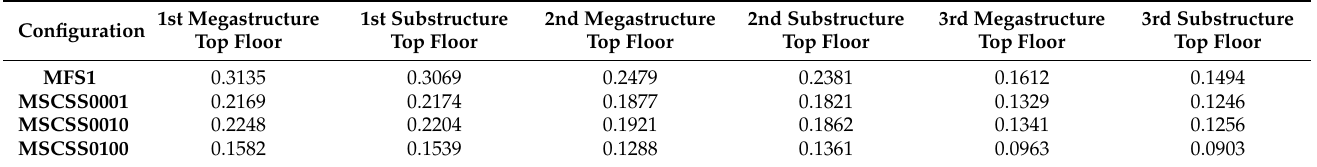
Table 5. The velocity response at a critical point of the investigated configurations under the Tangshan wave (m s − 1 ).